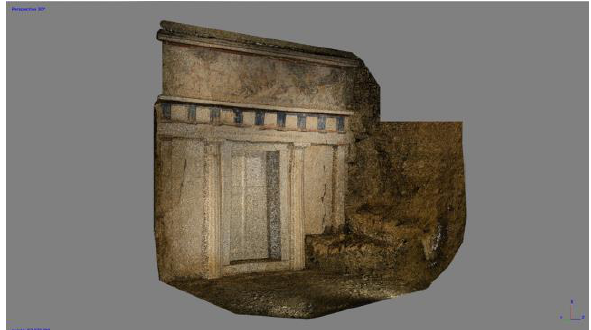
Figure 11. The Tomb of Alexander IV at Verghina. Cloud of points, detail from the west.